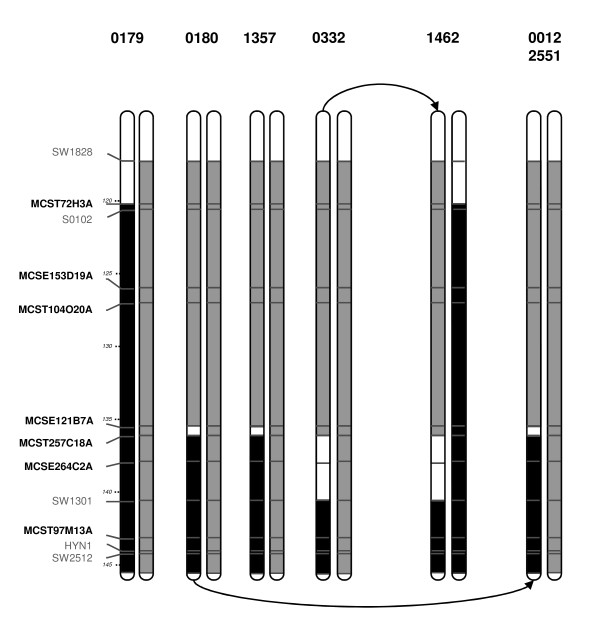
Haplotypes of the different recombinant sires progeny tested. Only the initial QTL interval between SW1828 and SW2512 microsatellites is reported on this figure. Position on the genetic map is indicated on the left. New microsatellites are indicated in black and bold. Haplotypes in QTL interval are represented for each sire, and breed origins are differentiated by colors (Meishan: black, Large White: grey, or unknown: white). All the MS segments have a common origin, LW chromosomes are unrelated. Recombinant chromosomes, identical by descent, are noted with an arrow.